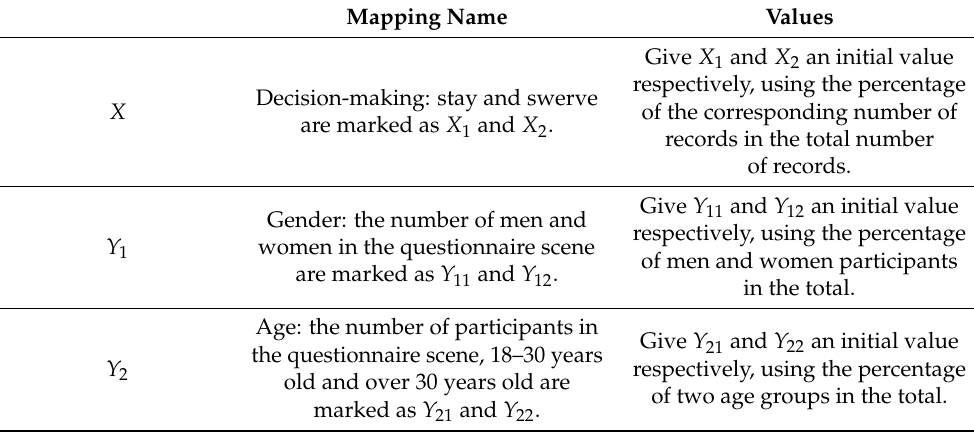
Table 4. Quantitative results of driving decision-making influencing